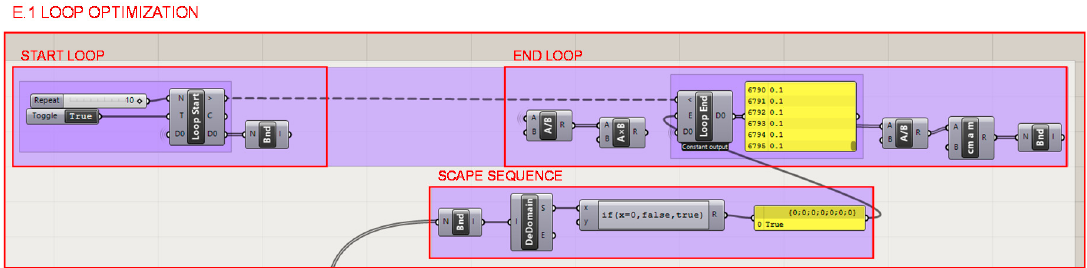
Figure 28. Programming structure definition for the generation of the structural optimization loop of the heel infill and shell.